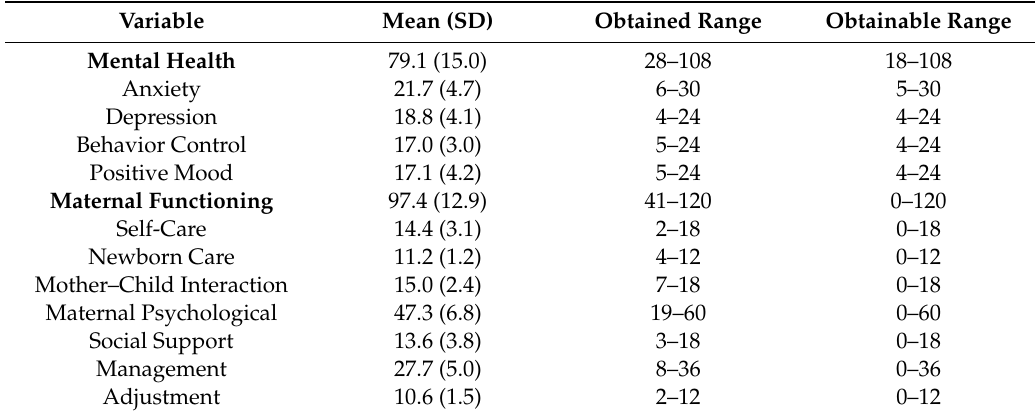
Table 2. The status of maternal functioning and mental health in women referred to health centers of Tabriz, Iran, 2019 ( n = 530).